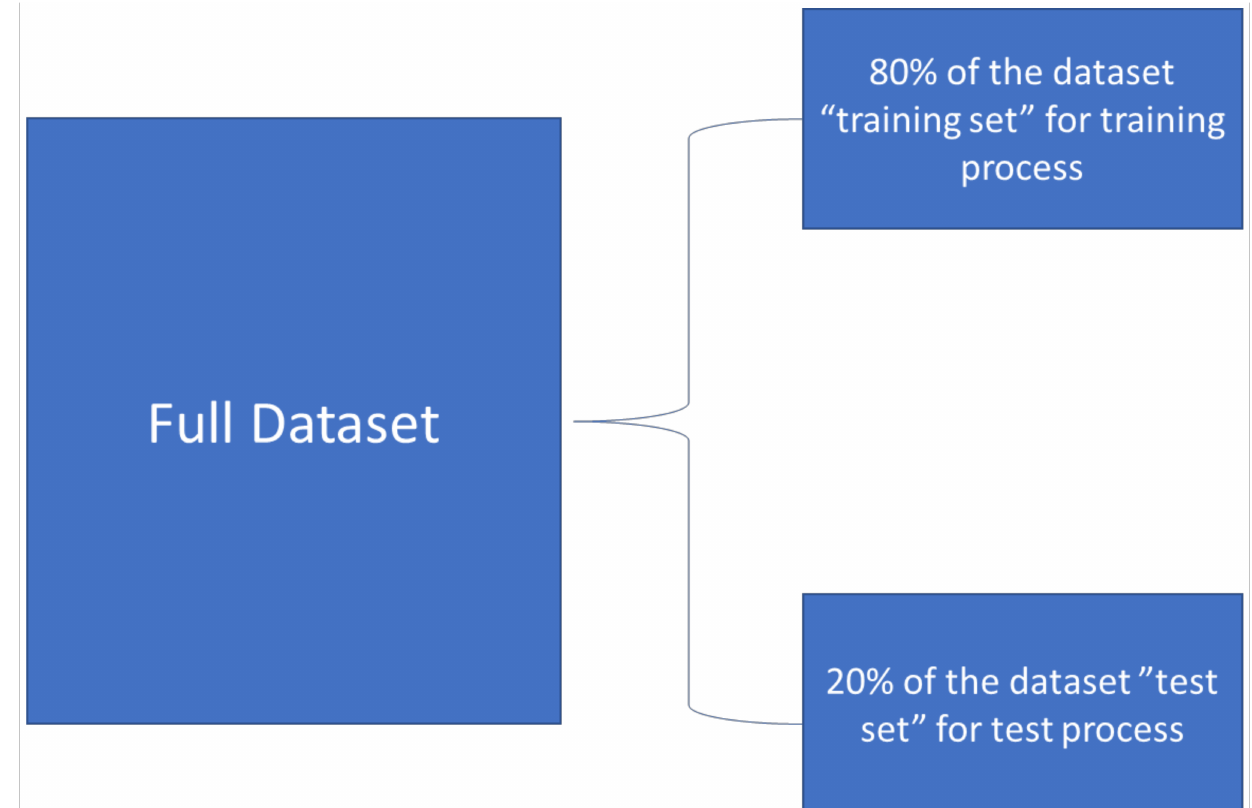
Figure 4. Extracted dataset separation into training set and test